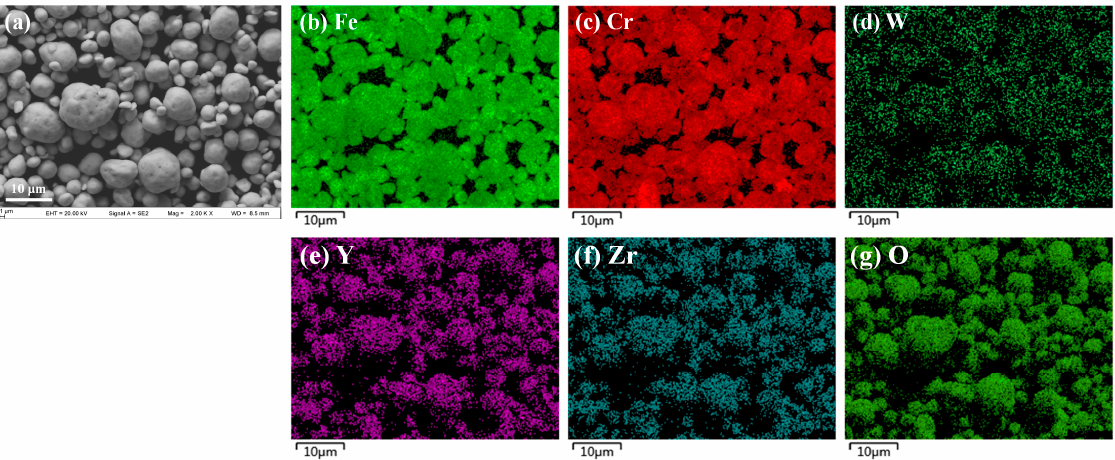
Figure 8. Morphology and corresponding EDS mapping results of the powders after 48 h of ball milling: ( a ) Morphology, ( b – g ) EDS mapping results. milling: ( a ) Morphology, ( b – g ) EDS mapping results.